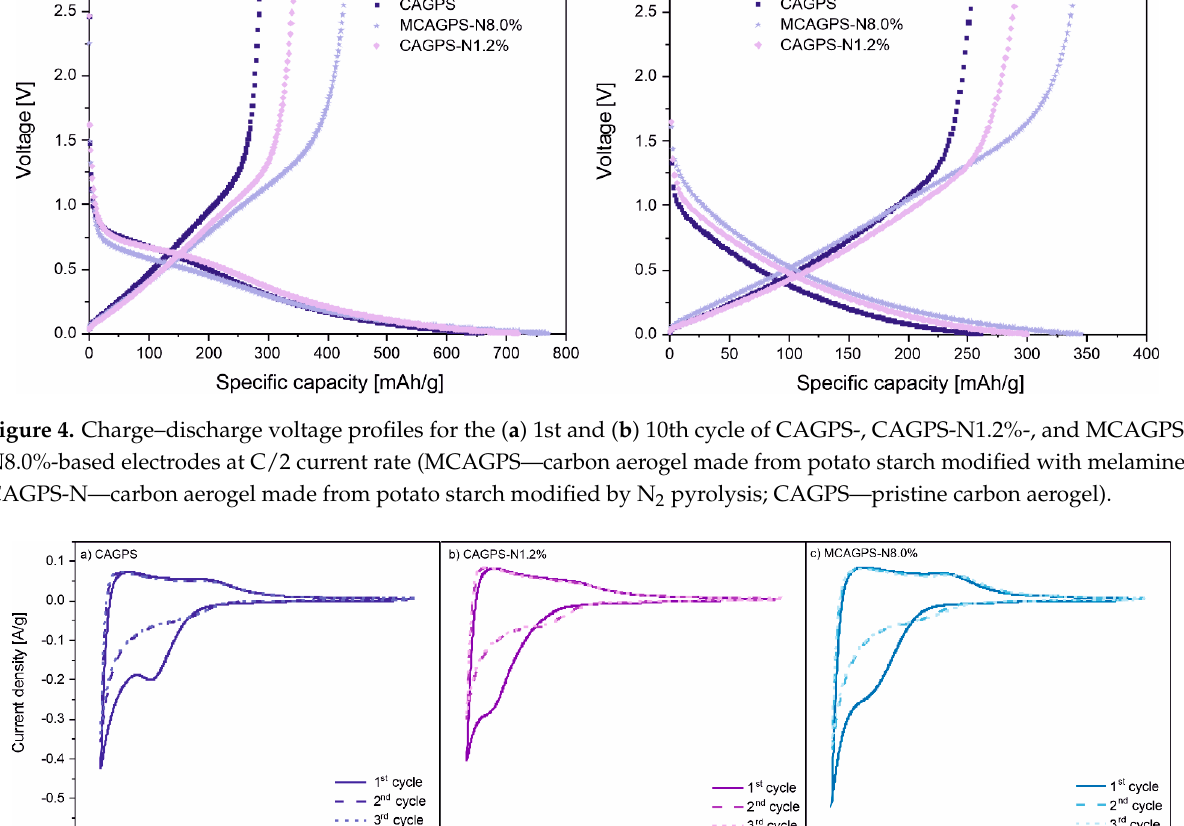
Figure 4. Charge–discharge voltage profiles for the ( a ) 1st and ( b ) 10th cycle of CAGPS-, CAGPS-N1.2%-, and MCAGPS- N8.0%-based electrodes at C/2 current rate (MCAGPS—carbon aerogel made from potato starch modified with melamine; CAGPS-N—carbon aerogel made from potato starch modified by N 2 pyrolysis; CAGPS—pristine carbon aerogel).